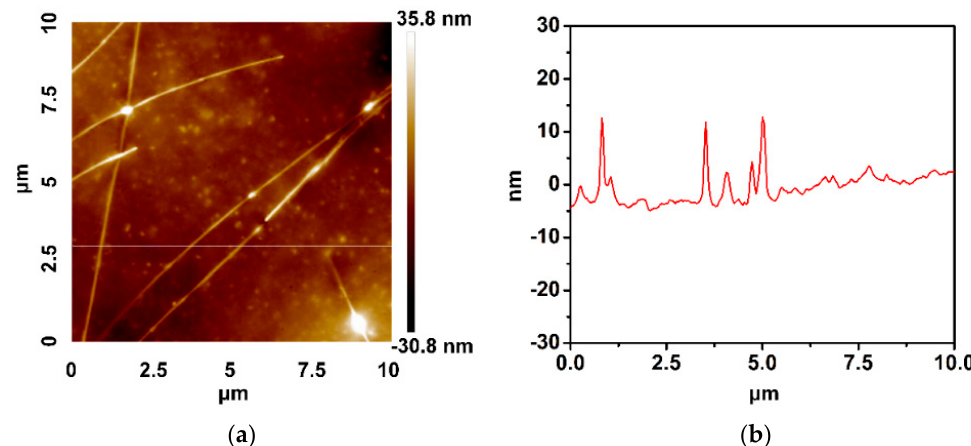
Figure 8. ( a ) Atomic force microscopy (AFM) image and ( b ) a scanned curve of the AgNW TCFs of work 2.